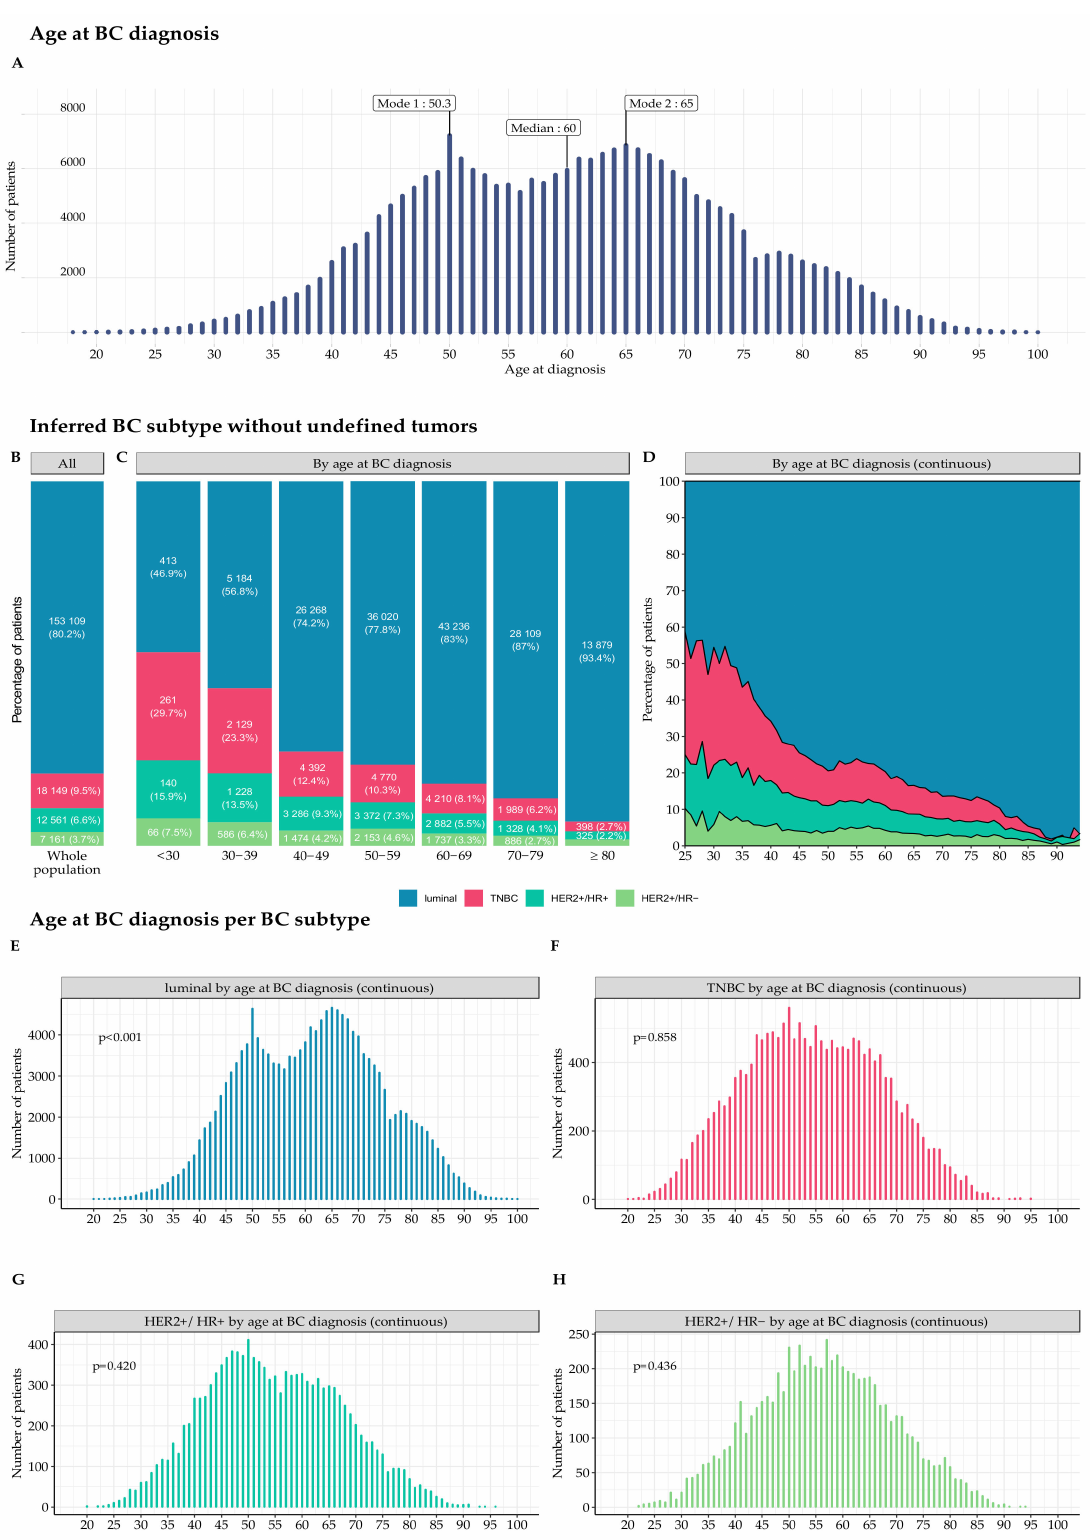
Figure 1. Age at BC diagnosis and inferred BC subtype, by age at BC diagnosis, excluding undefined tumors. ( A ) Number of patients included in the FRESH cohort, by age at BC diagnosis. The age distribution is bimodal, with two inferred incidence peaks at 50.3 and 65.0 years ( p -value for non- unimodality < 0.001). Median age is 60 years; ( B ) Inferred BC subtype percentages for the whole population, excluding undefined tumors ( n = 190,980); ( C ) Inferred BC subtype percentages per